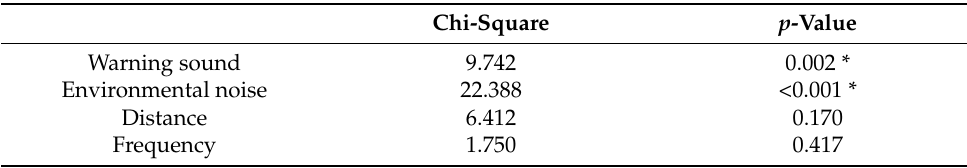
Table 1. Overall Kruskal–Wallis test results for detection rate.